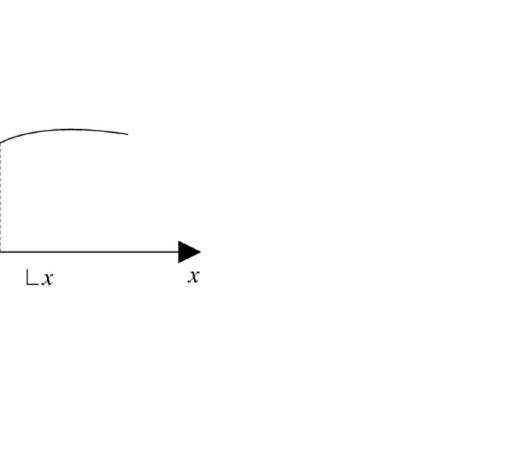
Fig 2. Value function of prospect